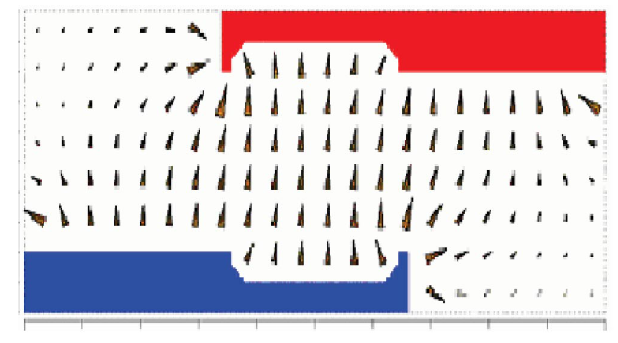
FIG. 4. (Color) Electrode shimming.